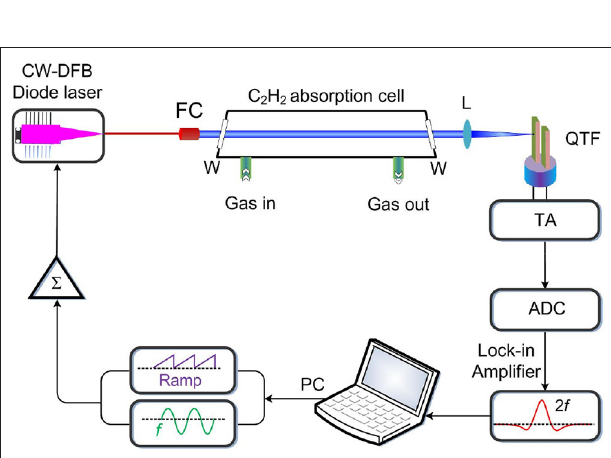
FIGURE 9 | The schematic of the QEPTS sensor. Reprinted with permission from [95] © The Optical Society.